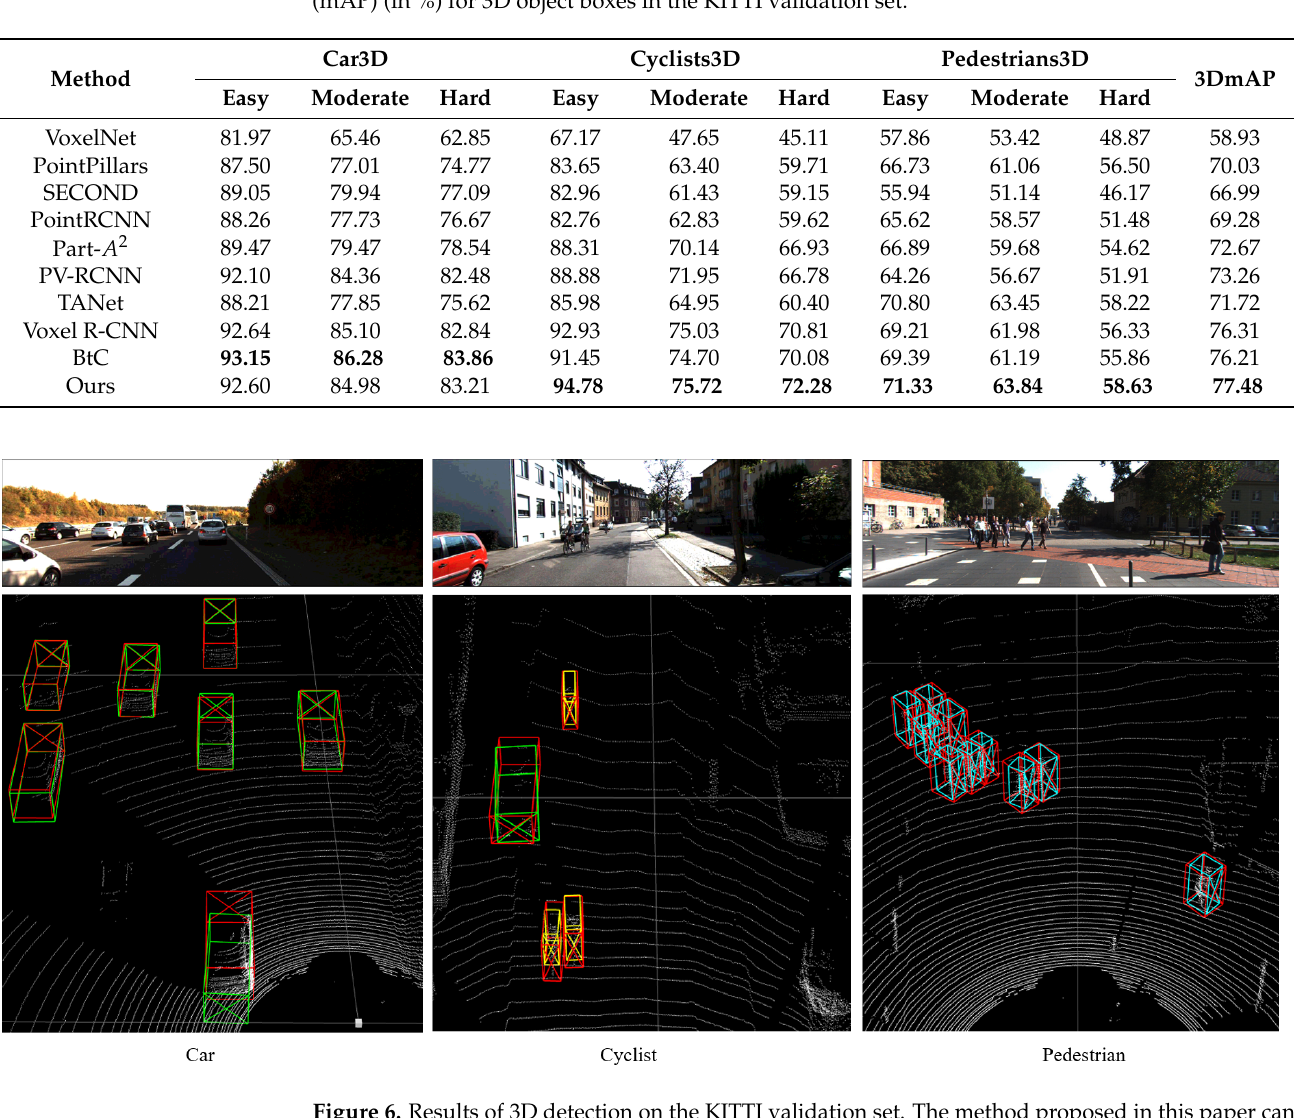
Figure 6. Results of 3D detection on the KITTI validation set. The method proposed in this paper can accurately detect the object in the point cloud. The red box represents the ground truth box of the object, the green box represents the detection result of the car, and the blue and yellow represent the detection result of the pedestrian and the cyclist,